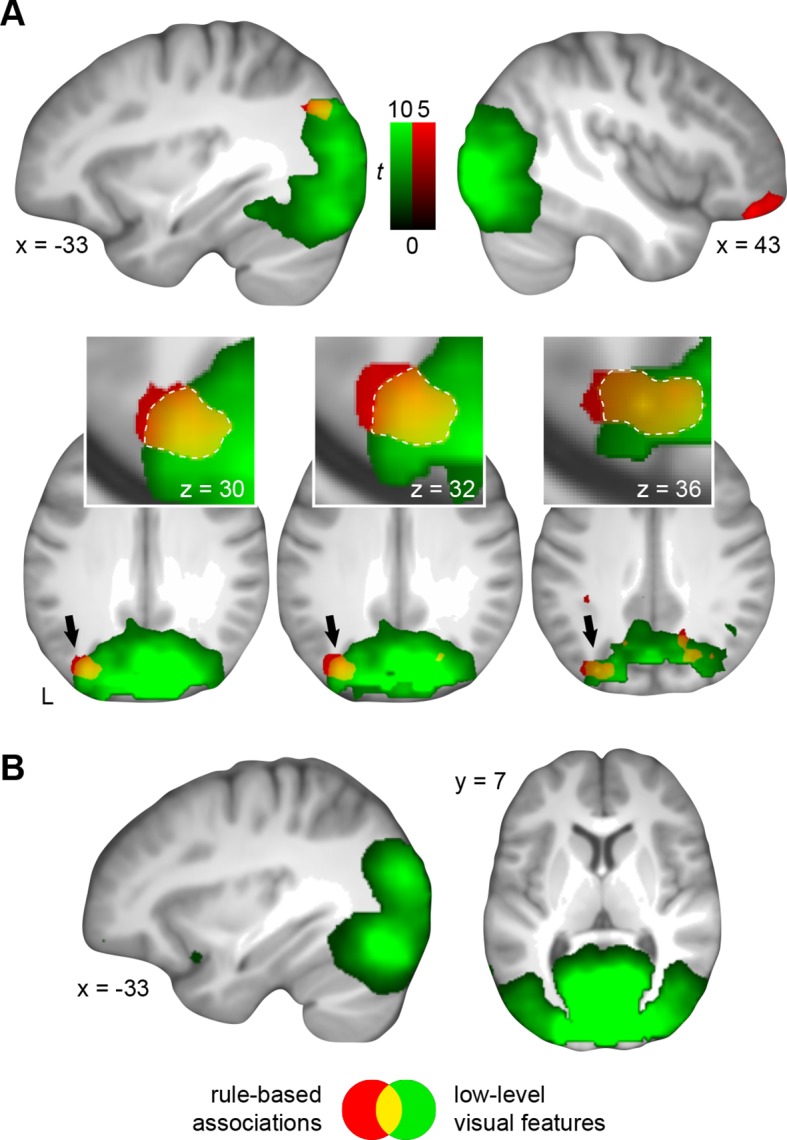
Multi-voxel representations of schema components.(A) The searchlight MVPA revealed distributed representations of both schema components (rule-based associations, low-level visual features). These representational levels converged within the AG (yellow). Three horizontal slices are shown as cut-outs and are magnified to appreciate the overlap (Table 3). (B) Only the multi-voxel patterns of low-level visual features were shared between day 1 and day 2. For display purposes, all maps were resliced to a voxel dimension of 0.5 mm isotropic and are shown at P < 0.001, uncorrected. Significant clusters are noted in Table 3. L – left.